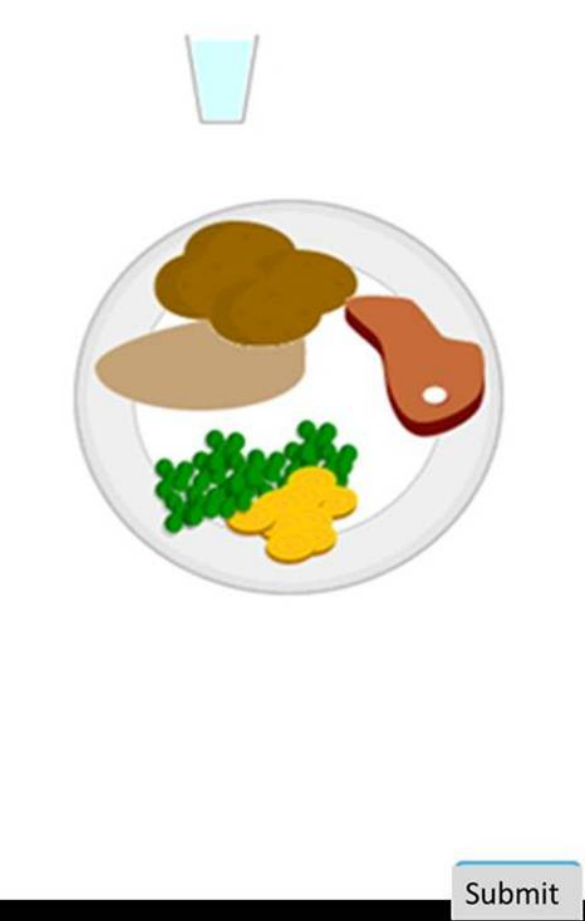
Figure 2. Example of the computer plate and listed food